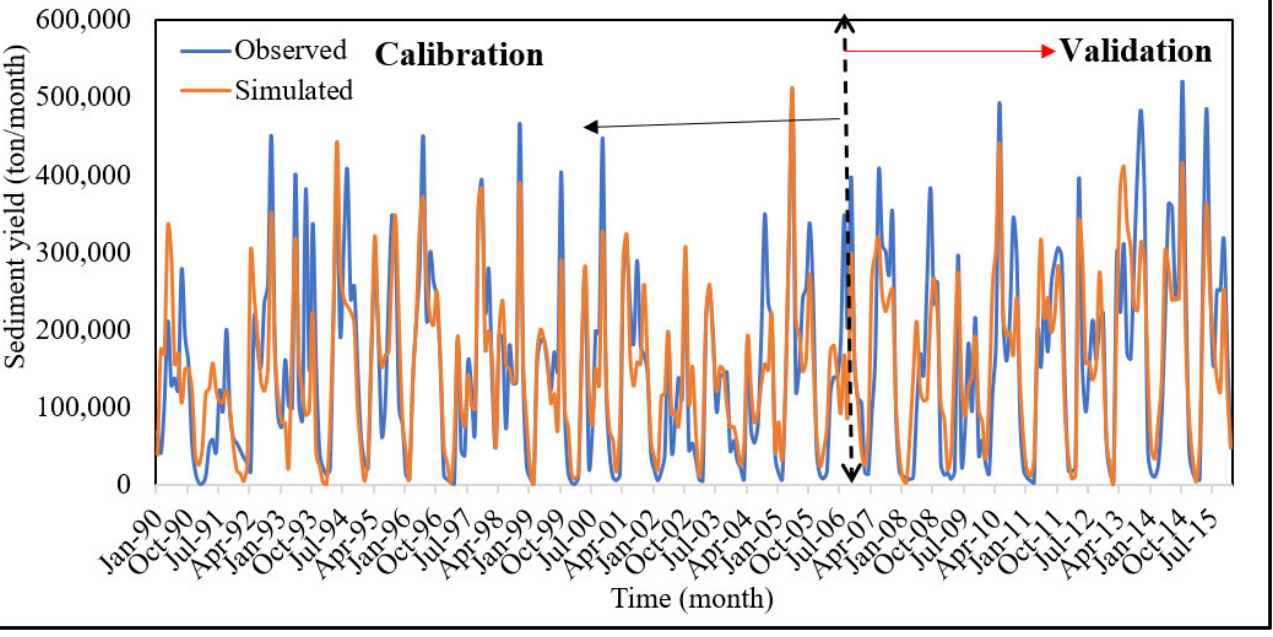
Figure 6. Monthly sediment yield calibration and validation (1990–2015).